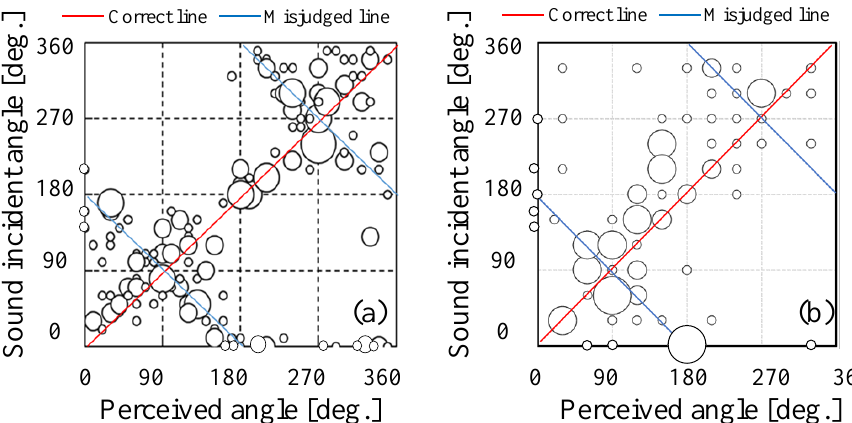
Figure 3. Sound localization performance for the cases in which the test signals were presented by ( a ) air-conducted sound and ( b ) bone-conducted sound [22].